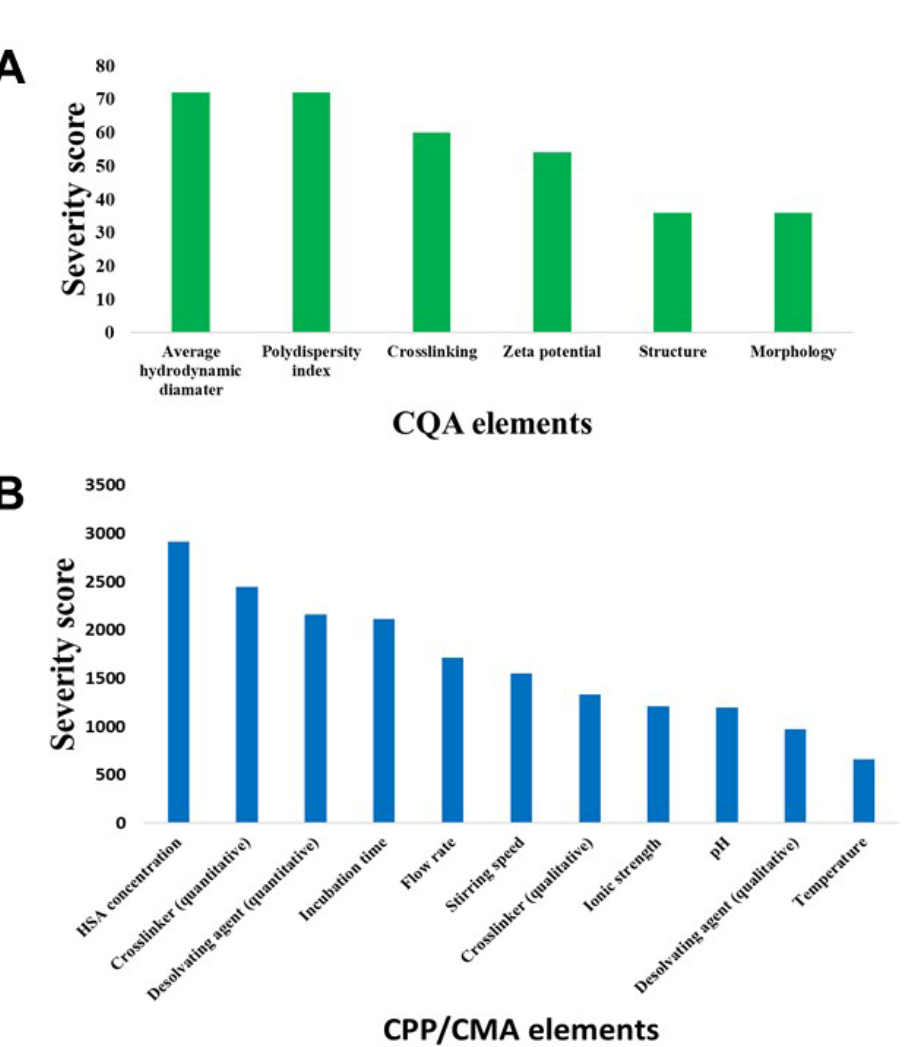
Figure 3. Probability-based quantitative estimation of possible risk factors associated with HSA nanoparticle formulation via the rapid coacervation preparation method. The software-calculated severity scores are depicted in the case of Critical Quality Attributes ( A ) and Critical Process Parame- ters/Critical Material Attributes ( B ).